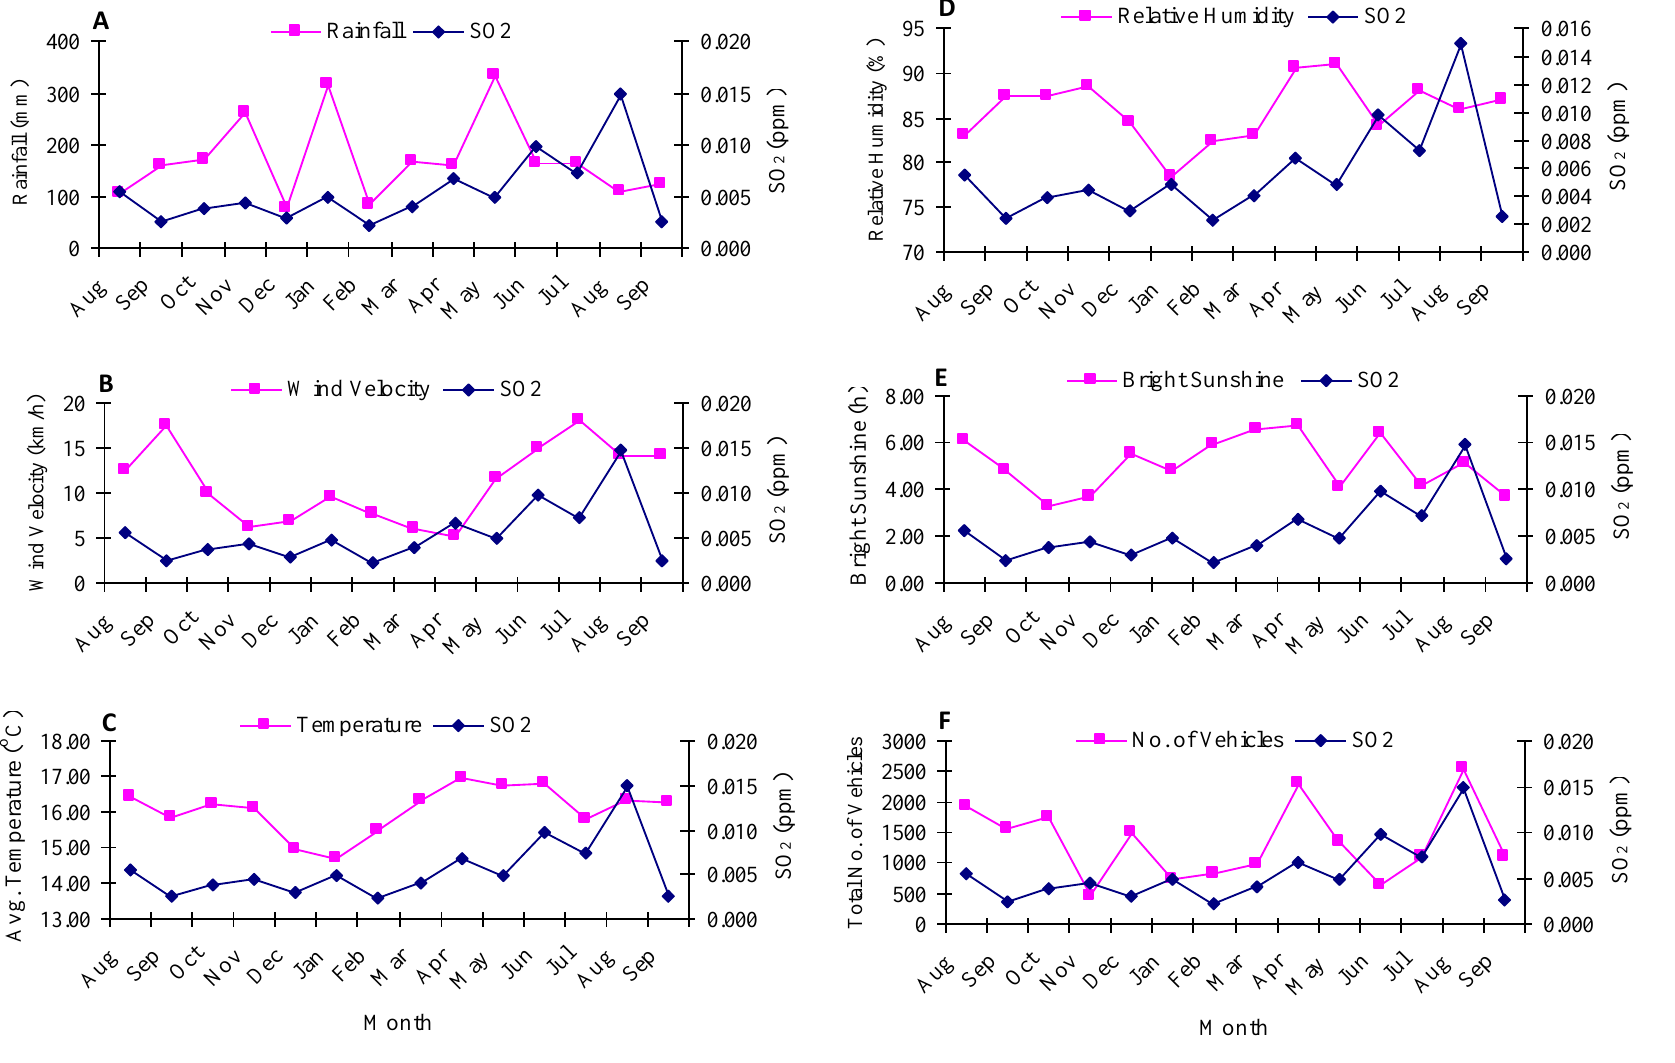
Figure 5. Variation of SO 2 with rainfall (A), wind velocity (B), average temperature (C), relative humidity (D), bright sunshine (E) and total number of vehicles (F) in